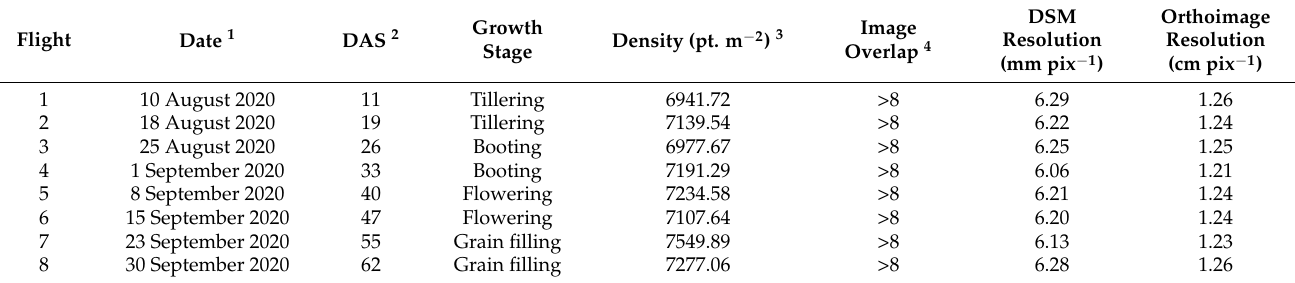
Table 2. Descriptive information from photogrammetric products.